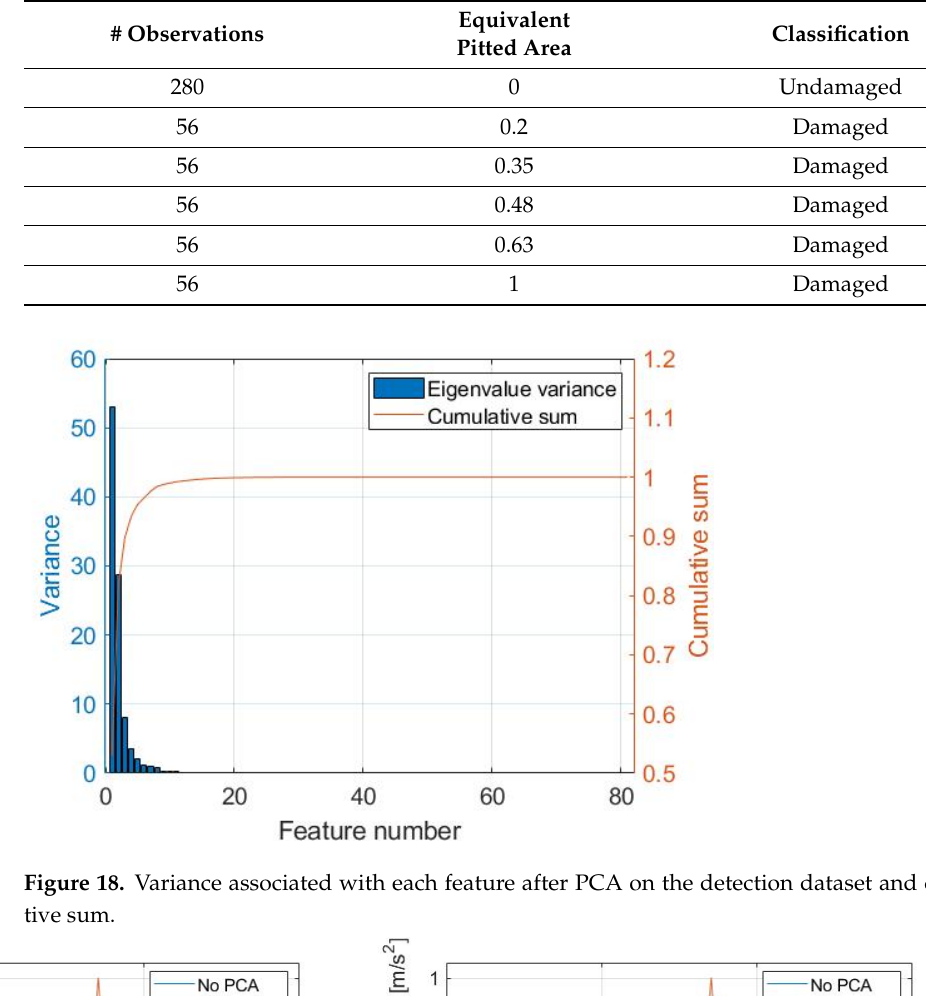
Table 4. Training-set composition for damage detection.